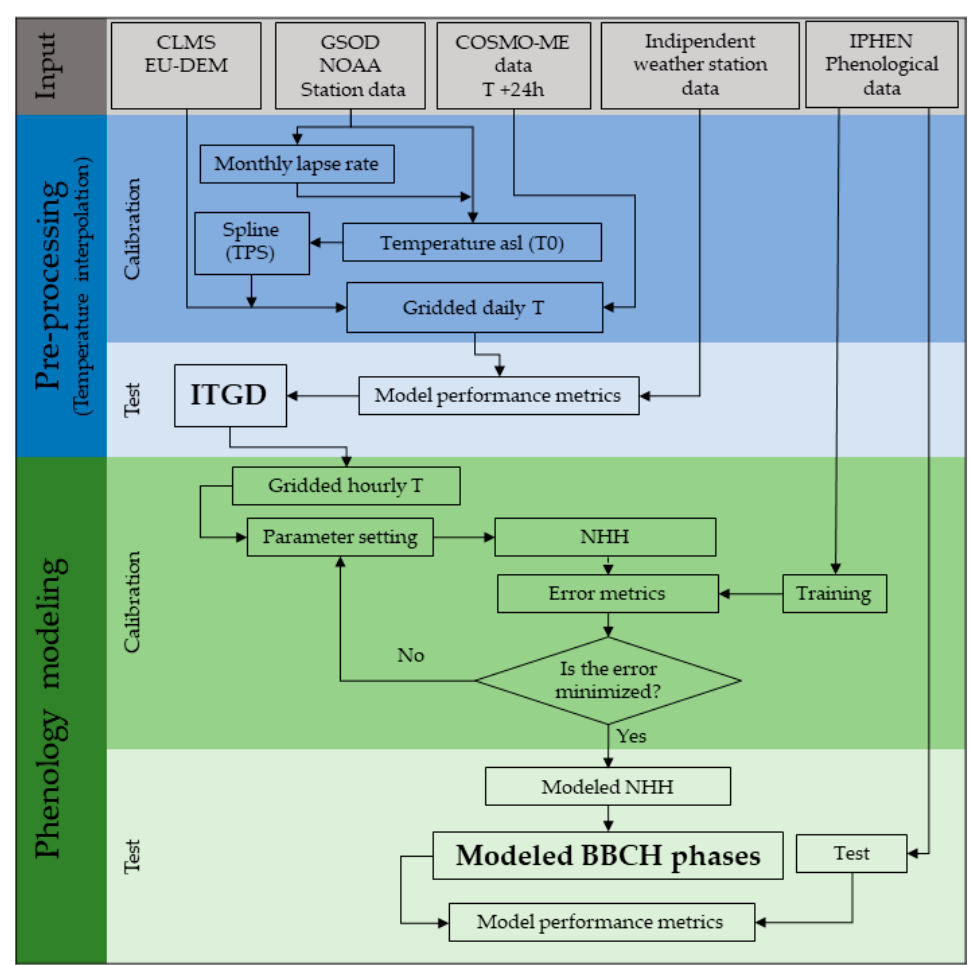
Figure 4. Flowchart of the procedure followed to develop the phenological